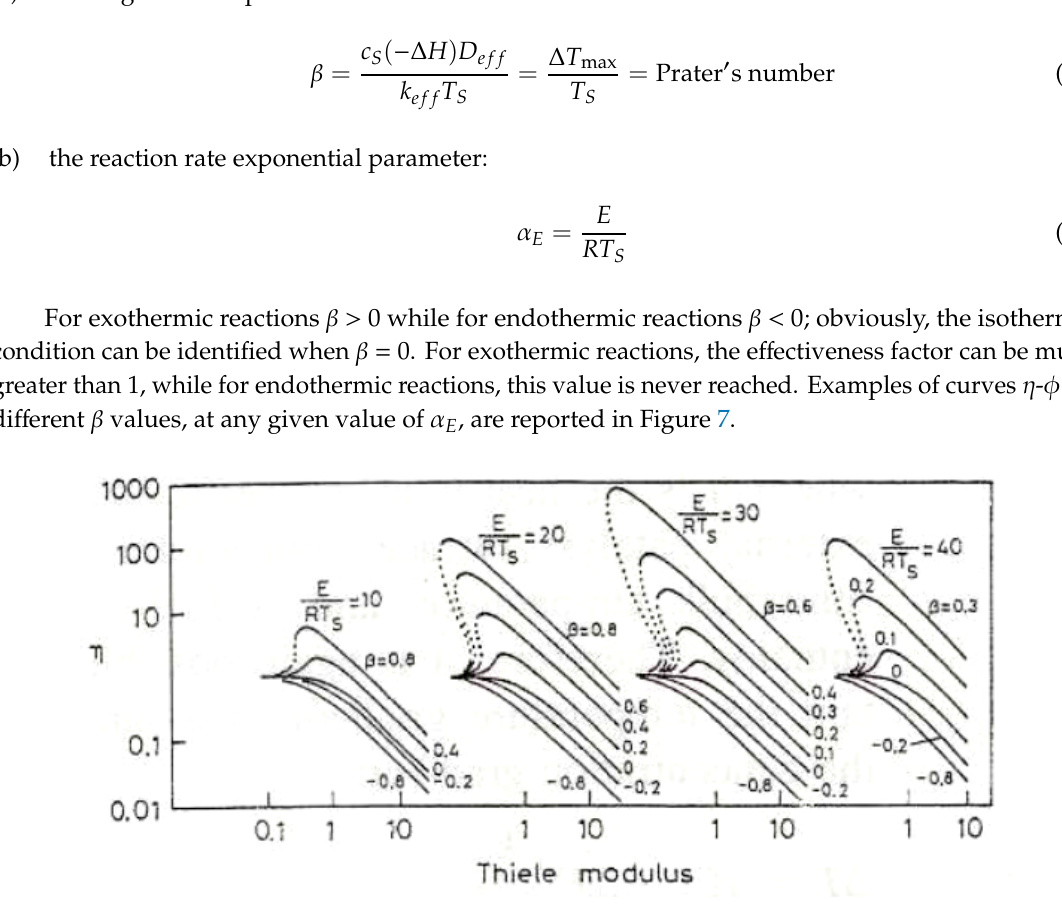
Figure 7. Effectiveness factors against the Thiele modulus in the case of both exothermic and endothermic reactions with an internal temperature gradient. Re-elaborated from Santacesaria [20] with the permission of Elsevier-Catalysis Today 1997.